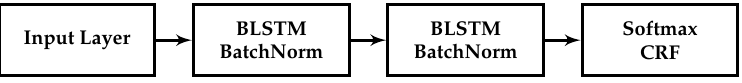
Figure 5. Architecture of the NER sequence labeling.